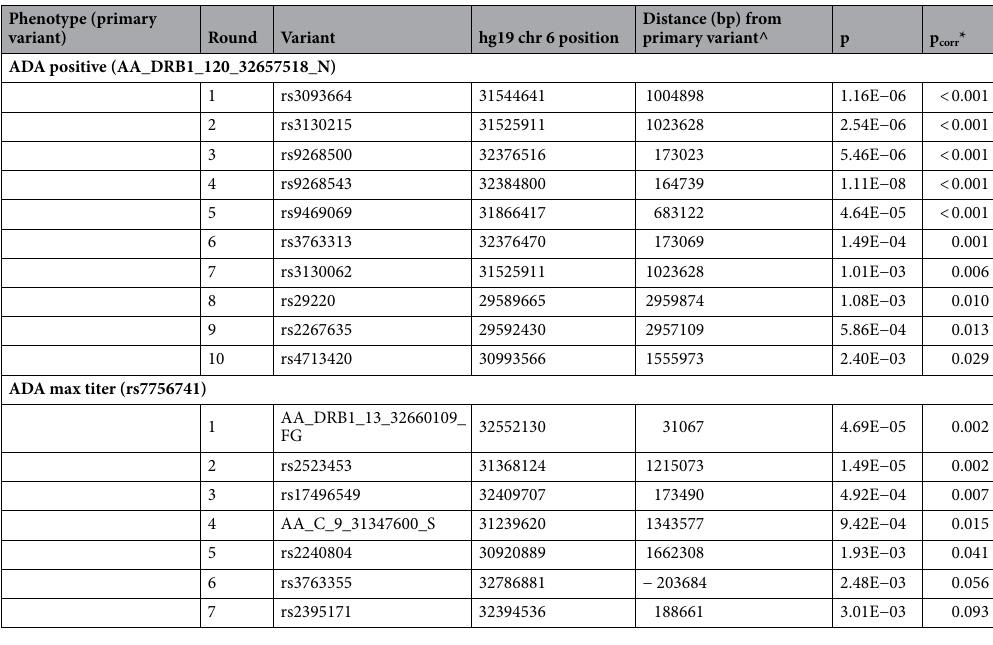
Table 3. Additional variants from sequential rounds of conditioning. *p value corrected for multiple testing from 1000 iterations of resampling (Methods). ^positive values are 5’ direction, negative are